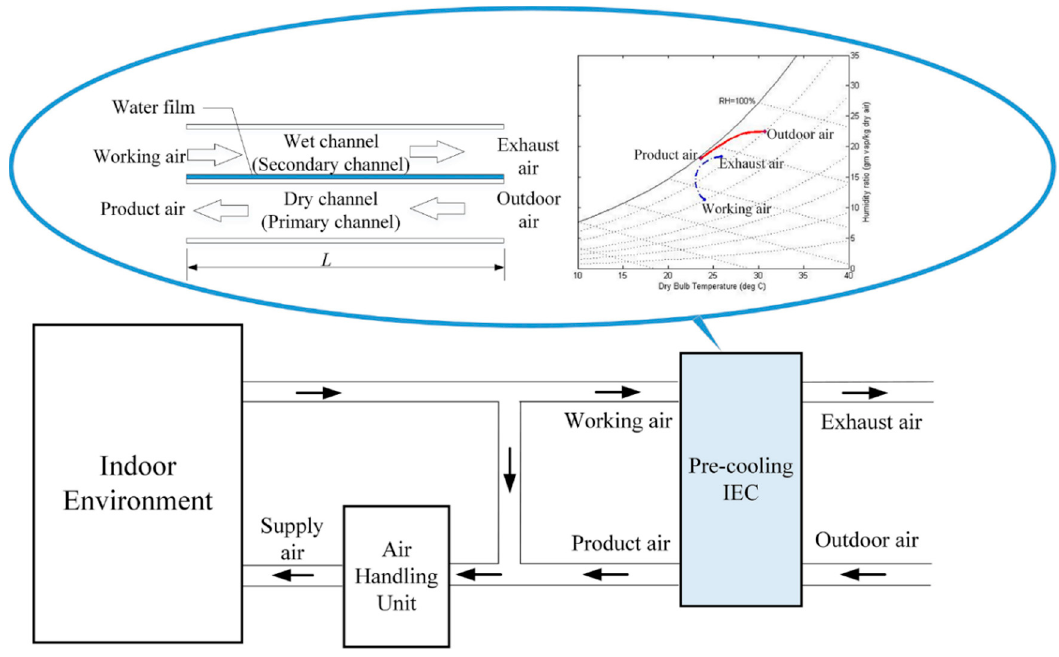
Figure 1. Schematic of the hybrid system with the integration of a pre-cooling IEC.